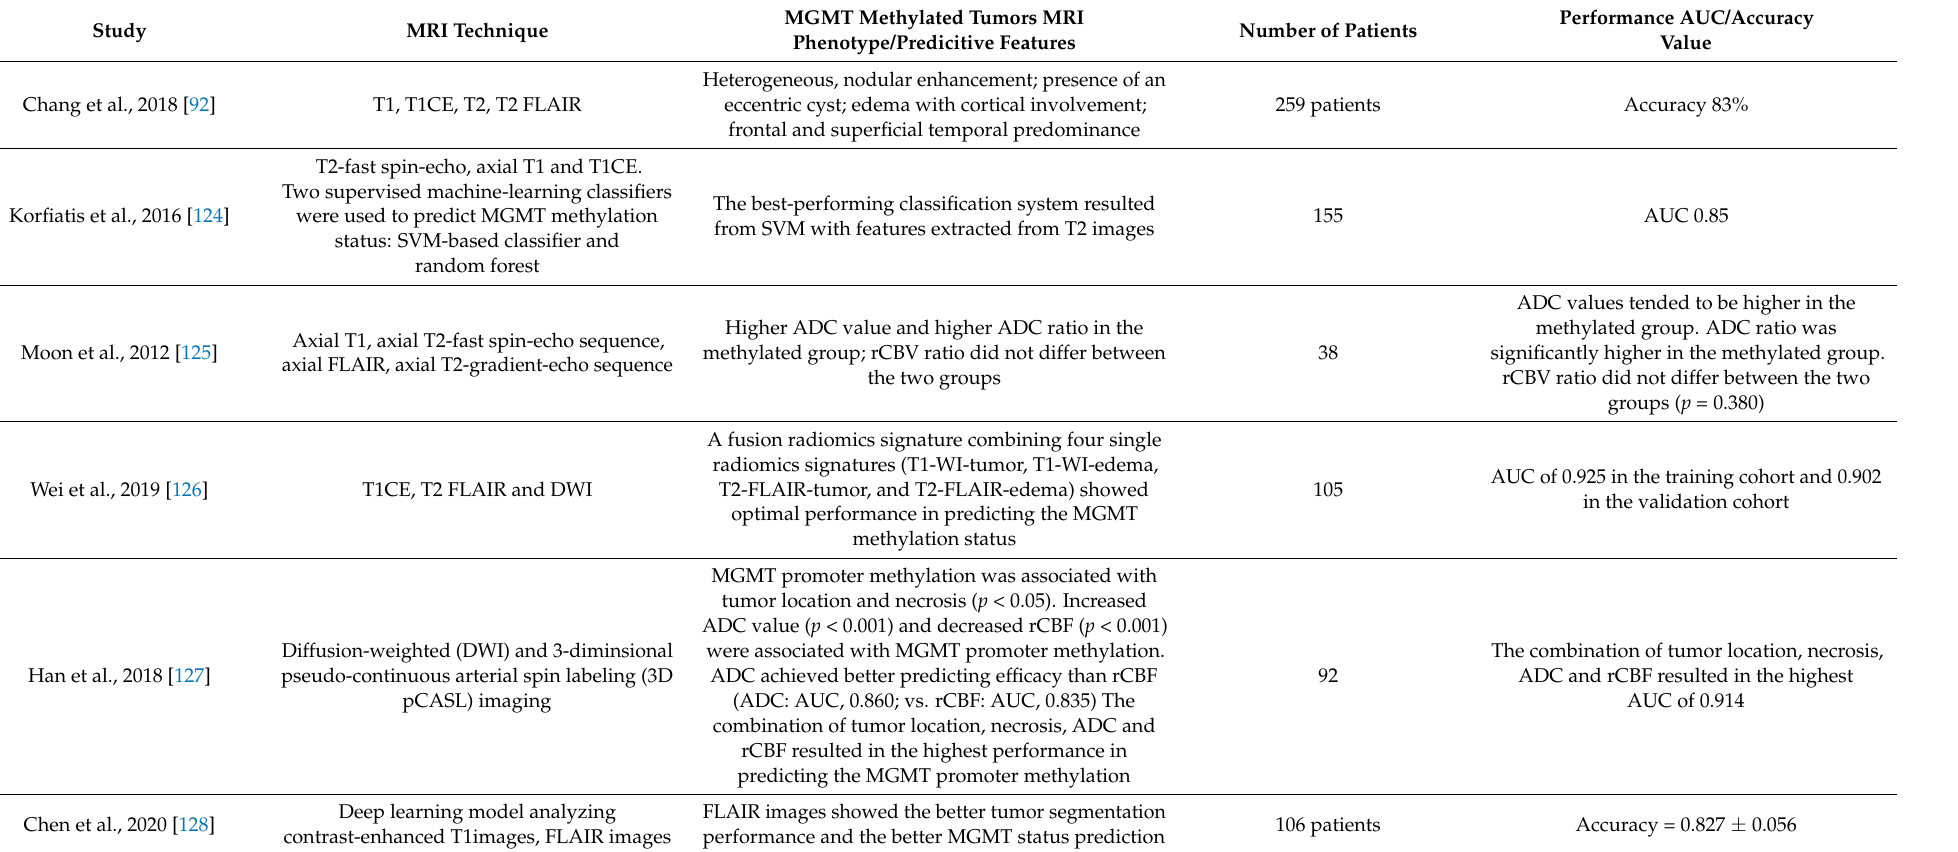
Table 2. Relevant radiogenomic studies predicting MGMT methylation